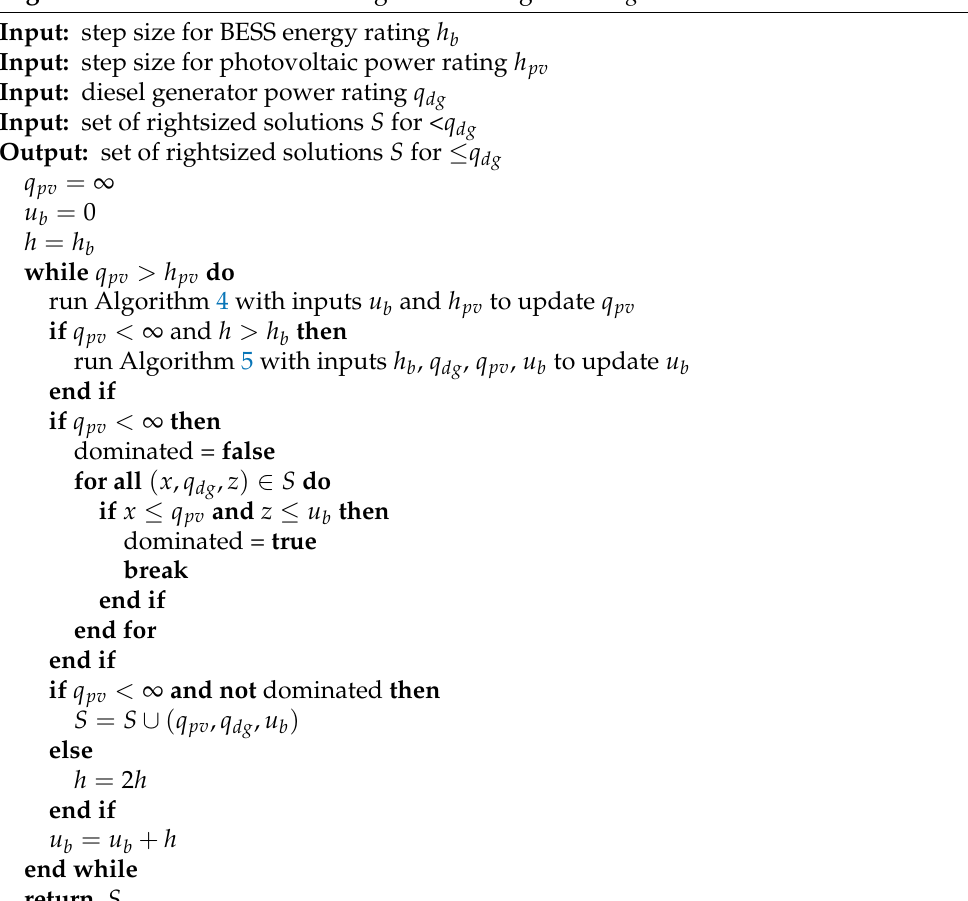
Algorithm 7 Identify all rightsized solutions.